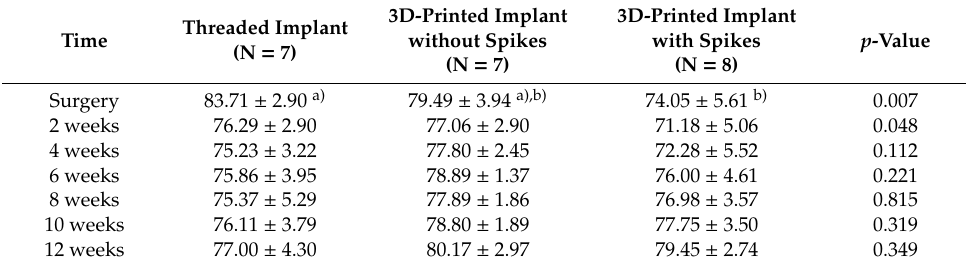
Table 2. Comparison of implant stability measurements among the three di ff erent